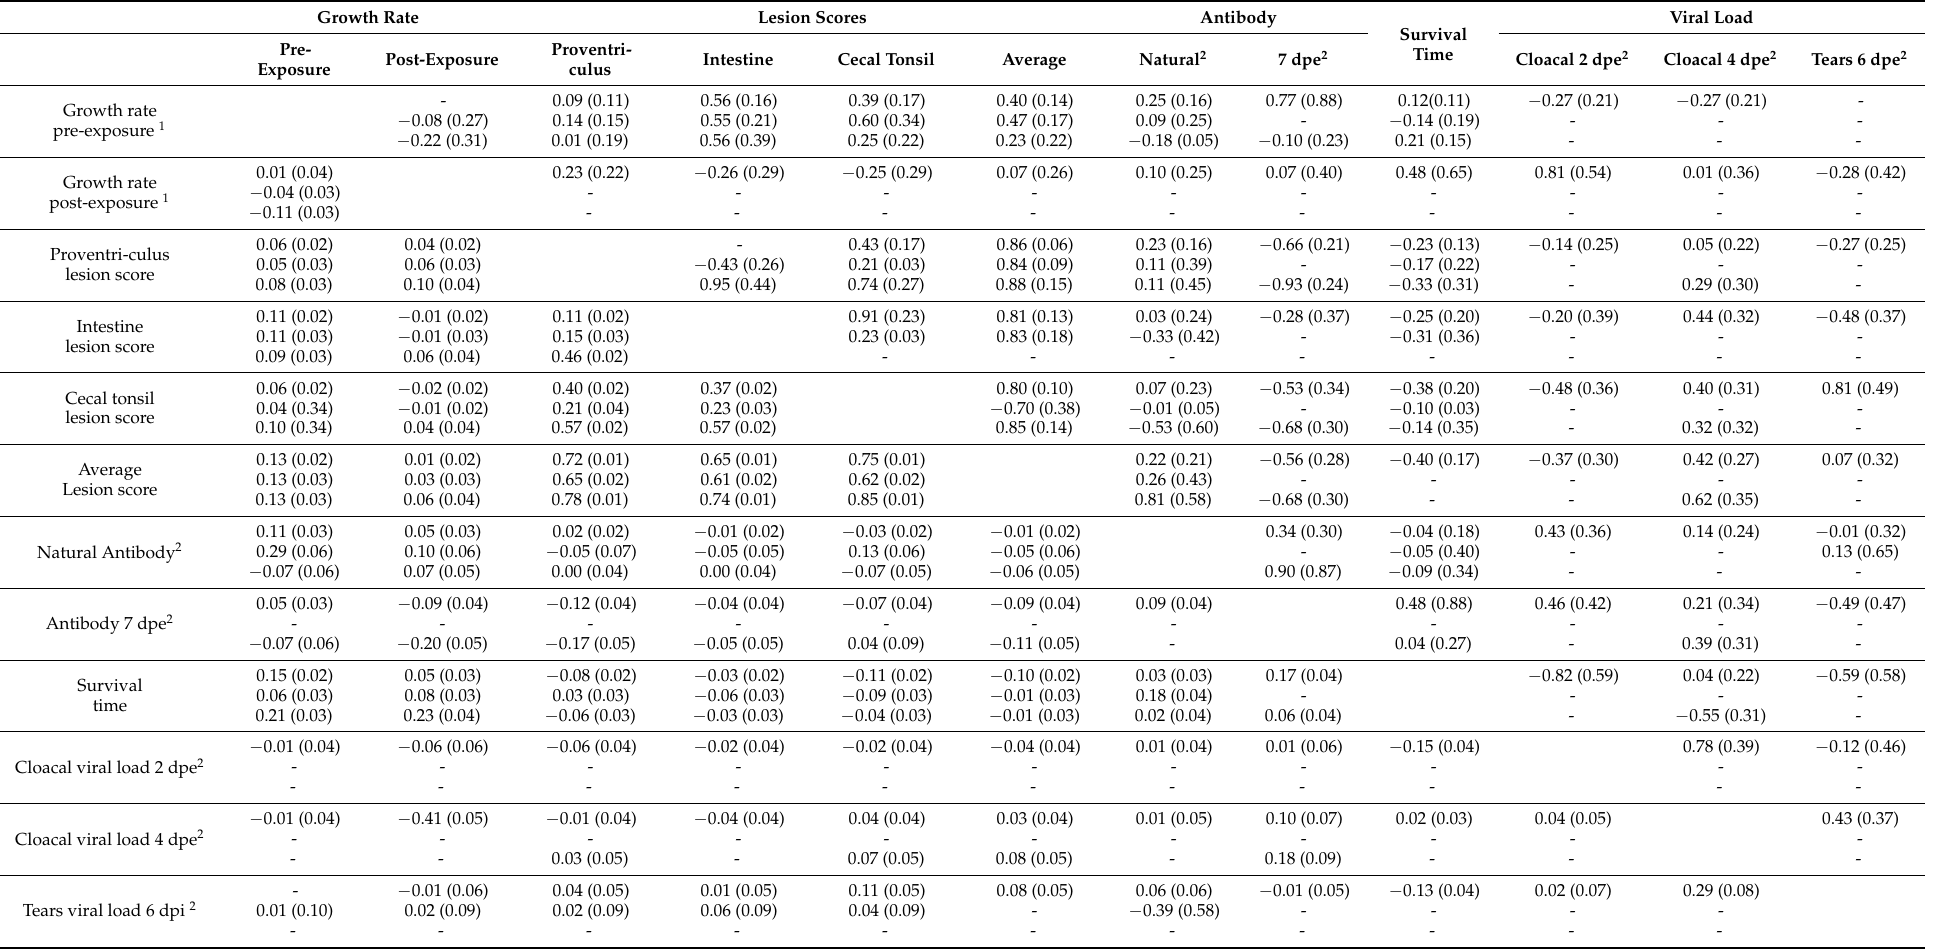
Table 3. Estimates (s.e) of phenotypic (lower diagonal) and genetic (upper diagonal) correlations analyses for the combined data (first row), Tanzania (second row), and Ghana (third row). Growth Rate Lesion Scores